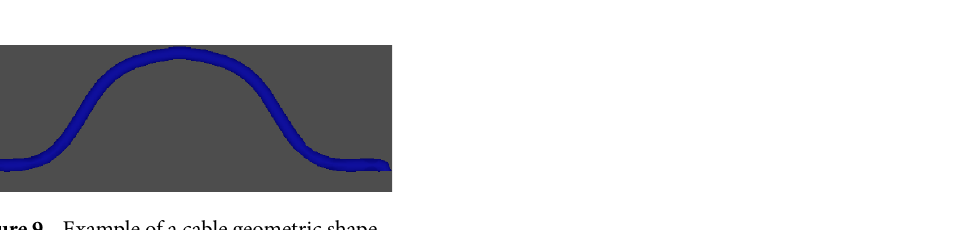
Figure 9. Example of a cable geometric